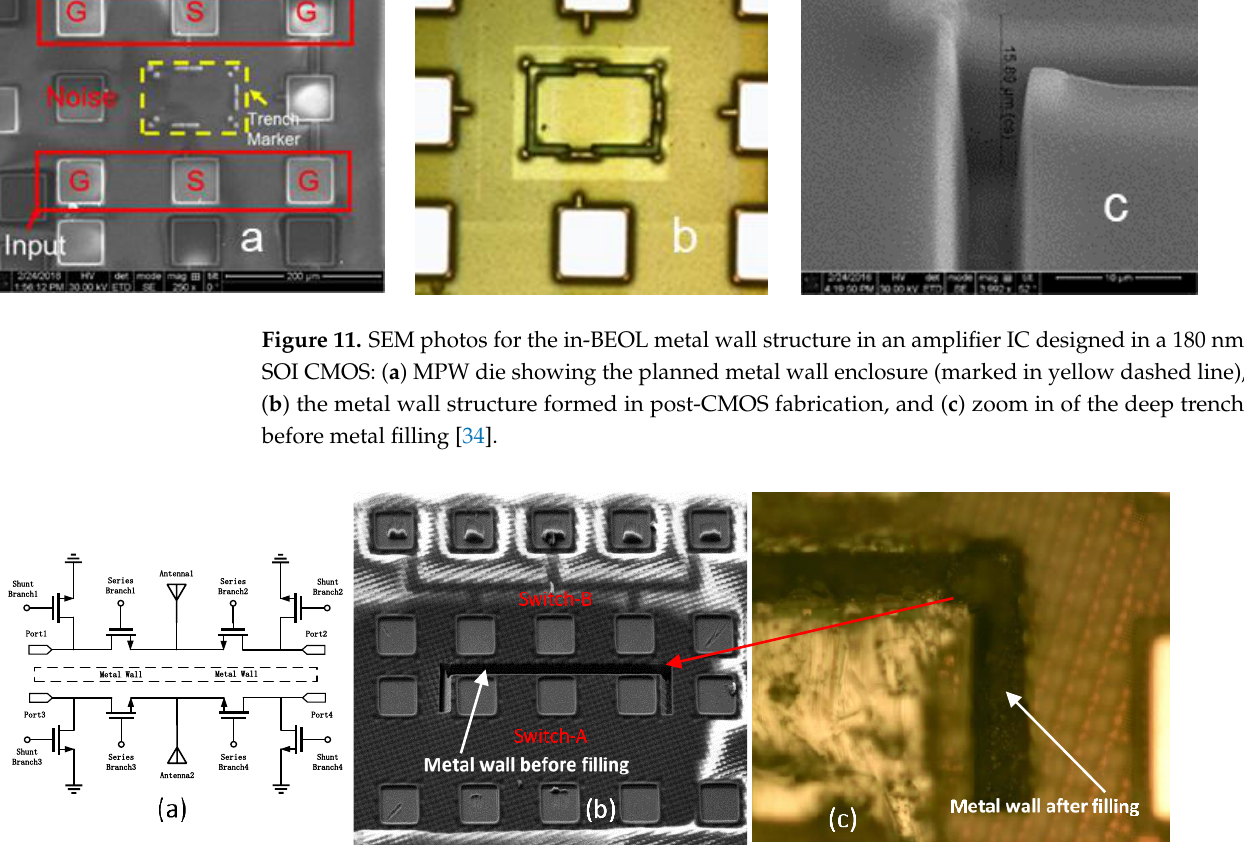
Figure 12. In-BEOL metal wall structure in an SPDT RF switch IC designed in a 45 nm SOI CMOS: ( a ) SPDT schematic, ( b ) partial metal wall trench etched by FIB, and ( c ) zoom in of the silver-filled metal wall structure [35].